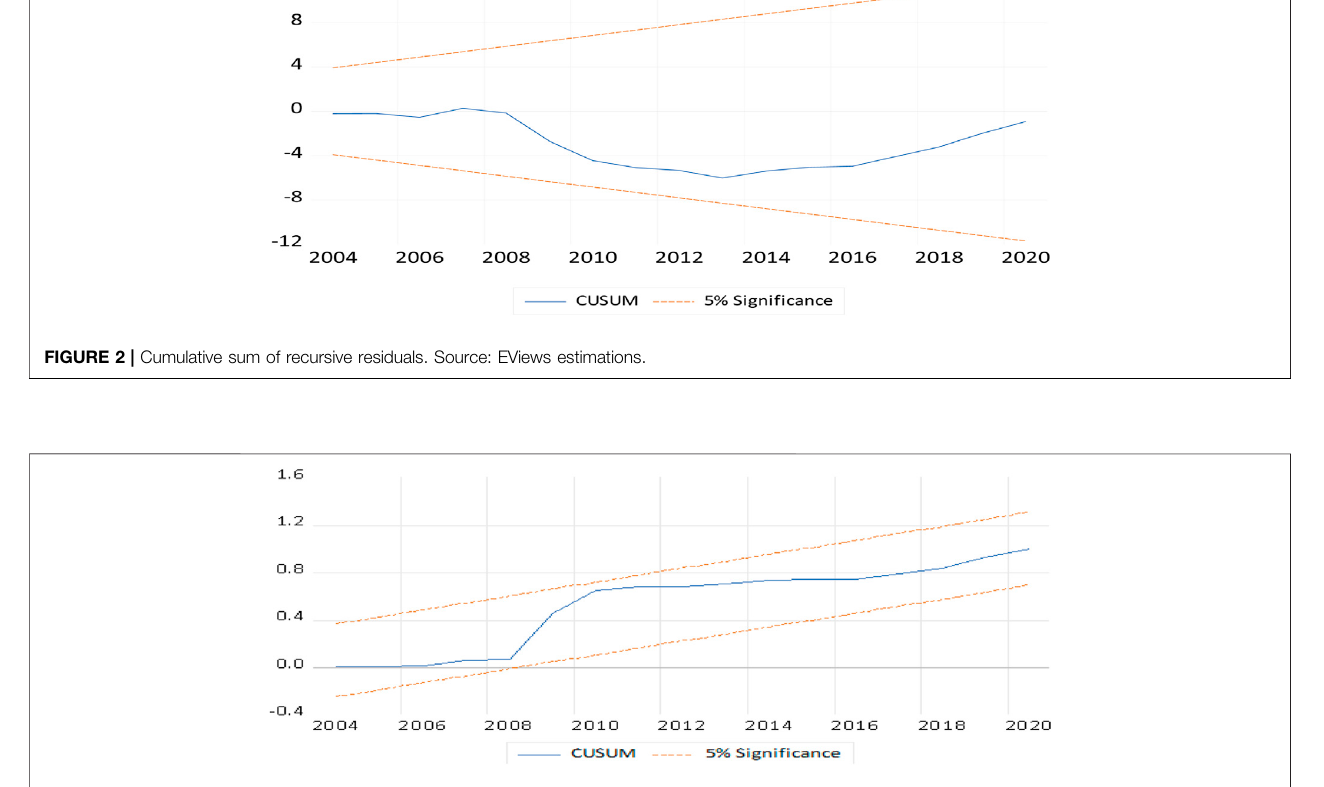
FIGURE 3 | Cumulative sum of squares of recursive residuals. Source: EViews